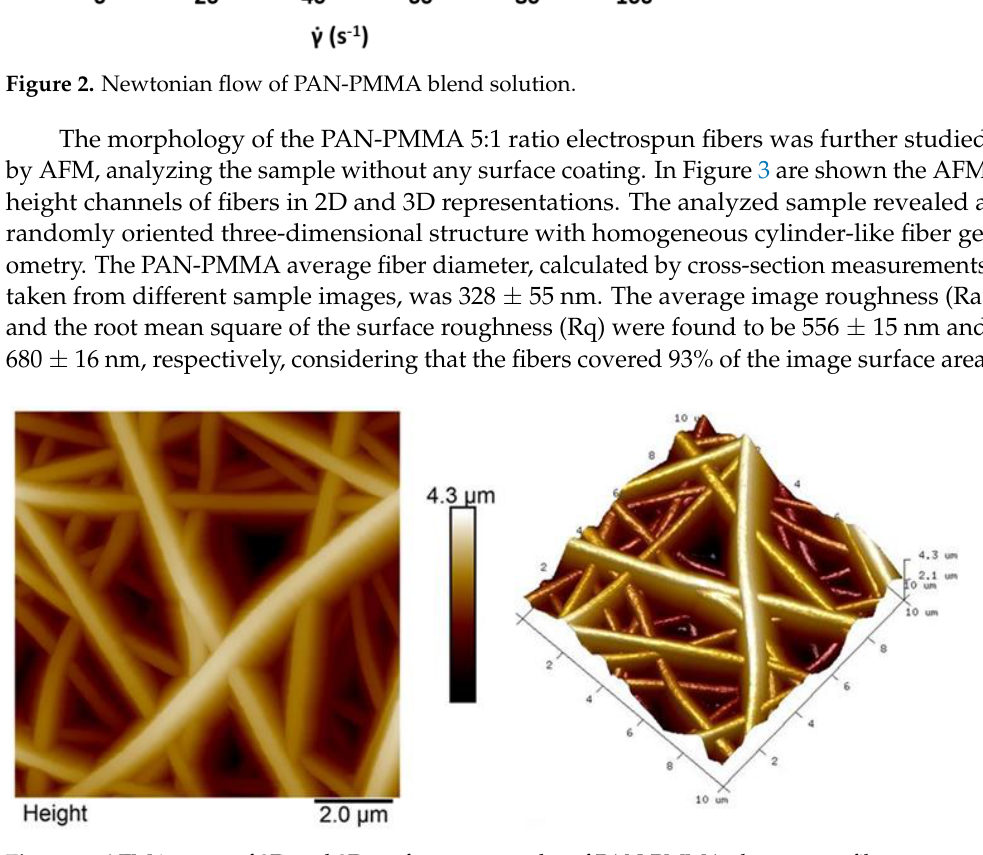
Figure 3. AFM images of 2D and 3D surface topography of PAN-PMMA electrospun fibers.